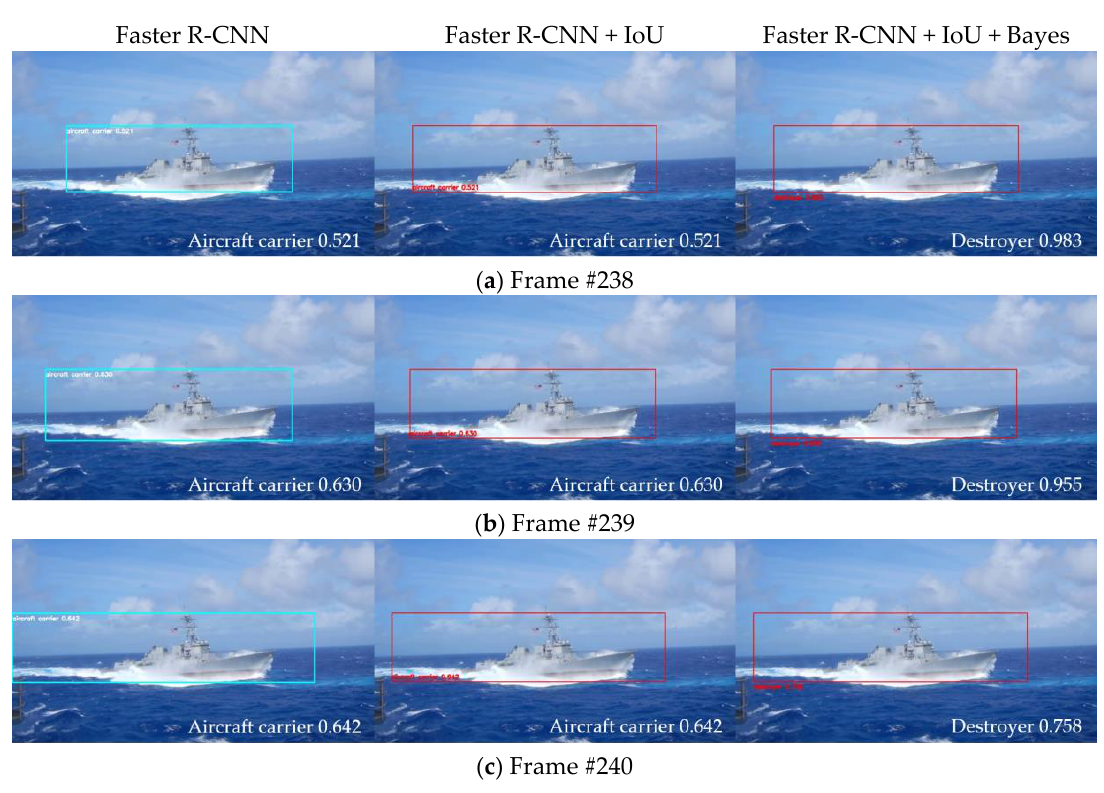
Figure 11. Captured images from Interval 4.